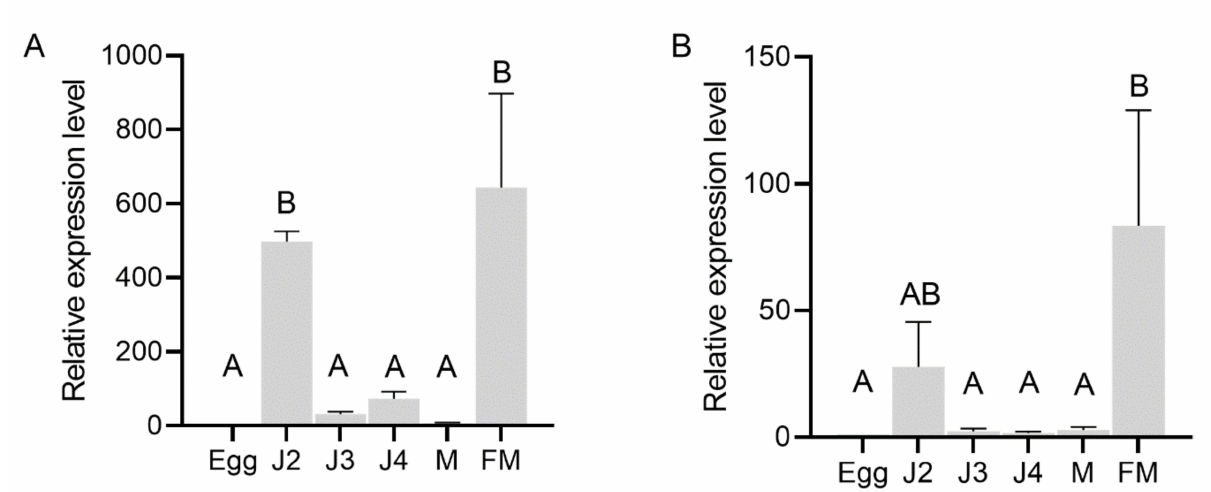
Figure 5. Relative expression level of AbGH16s in different developmental stages of A. besseyi . ( A ) AbGH16-1; ( B ) AbGH16- 2. The bars indicate the standard deviation of mean ( n = 3) and different letters on the bar indicate significant differences ( p < 0.01) between nematode specimens by Tukey’s test. M = male and FM =